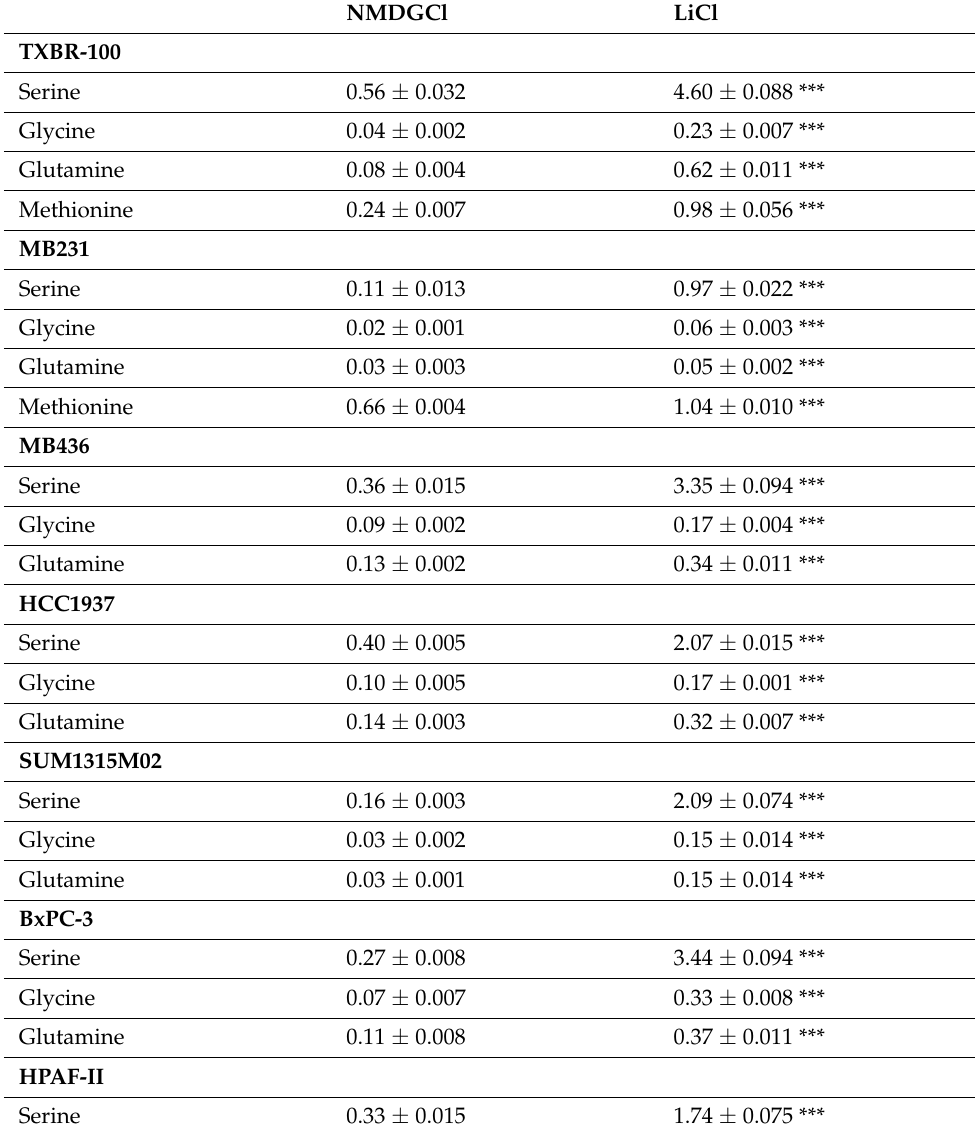
Table 1. SLC38A5 transport activity in TNBC and pancreatic cancer cells. Values (pmol/mg/15 min) are mean ± SEM. ***- p <